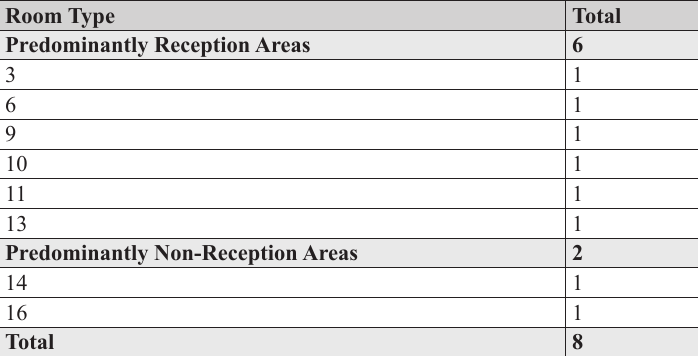
Table 4: The distribution of Venus Pompeiana representations in domestic contexts across room types Room Type Total Predominantly Reception Areas